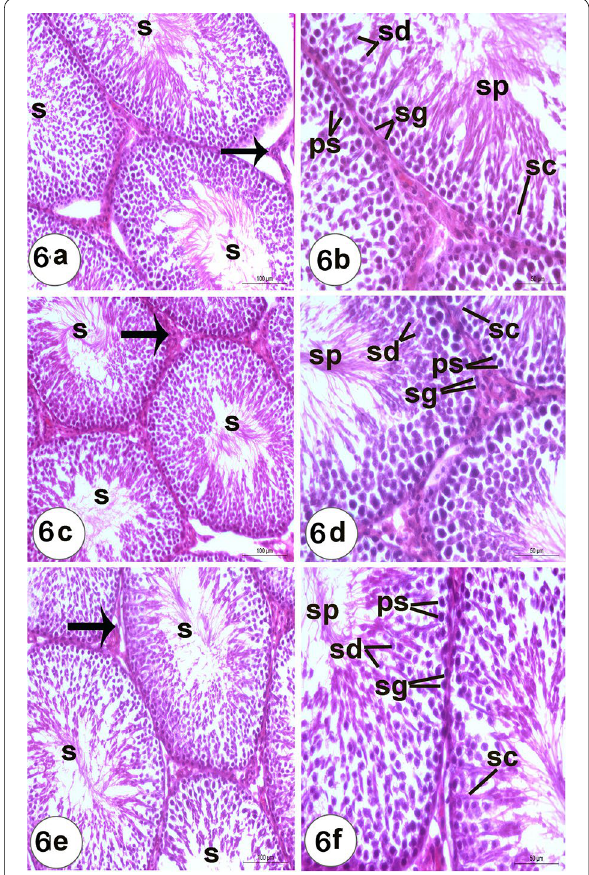
Fig. 6 a , c & e Photomicrographs of a sections of testis of a control water, corn oil and quercetin rats showing seminiferous tubules (S) and interstitial tissue containing Leydig cells (It) (Scale bar 100 µm). b , d & f Higher magnification of a , c & e sections = showing spermatogonia (Sg) resting upon the basal lamina of the seminiferous tubules that are oval in shape, primary spermatocytes (Ps), recognized by their large nuclei containing coarse clumps of chromatin, spermatids (Sd) with rounded nuclei, Sertoli cells (Sc) with nuclei located basally, and sperms in the lumen of the tubules (Sp) (Scale bar 50 µm) =